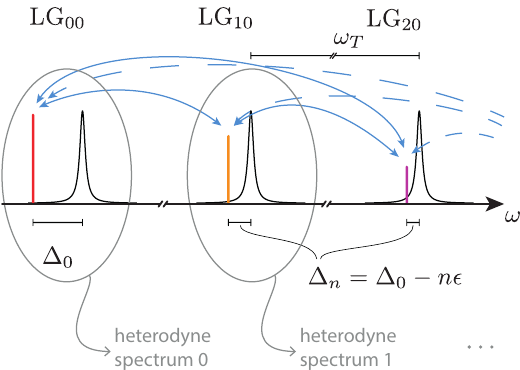
Figure 8: Modulation scheme for ε > 0. The detuning ∆ modes (lineshapes indicated by the Lorentzian peaks spaced by ω creasingly smaller. For weak PM, the amplitudes of the sidebands (colored lines) decrease. The blue arrows indicate the coupling between the different cavity modes due to the interaction with the atomic system. The spectra in the vicinity of the different modes of the cavity can be conveniently separated with a heterodyne de- tection system by tuning the frequency of the local oscillator close to a cavity mode frequency and electronically filtering out the contributions from the modes. This results in several heterodyne spectra as indicated by the grey